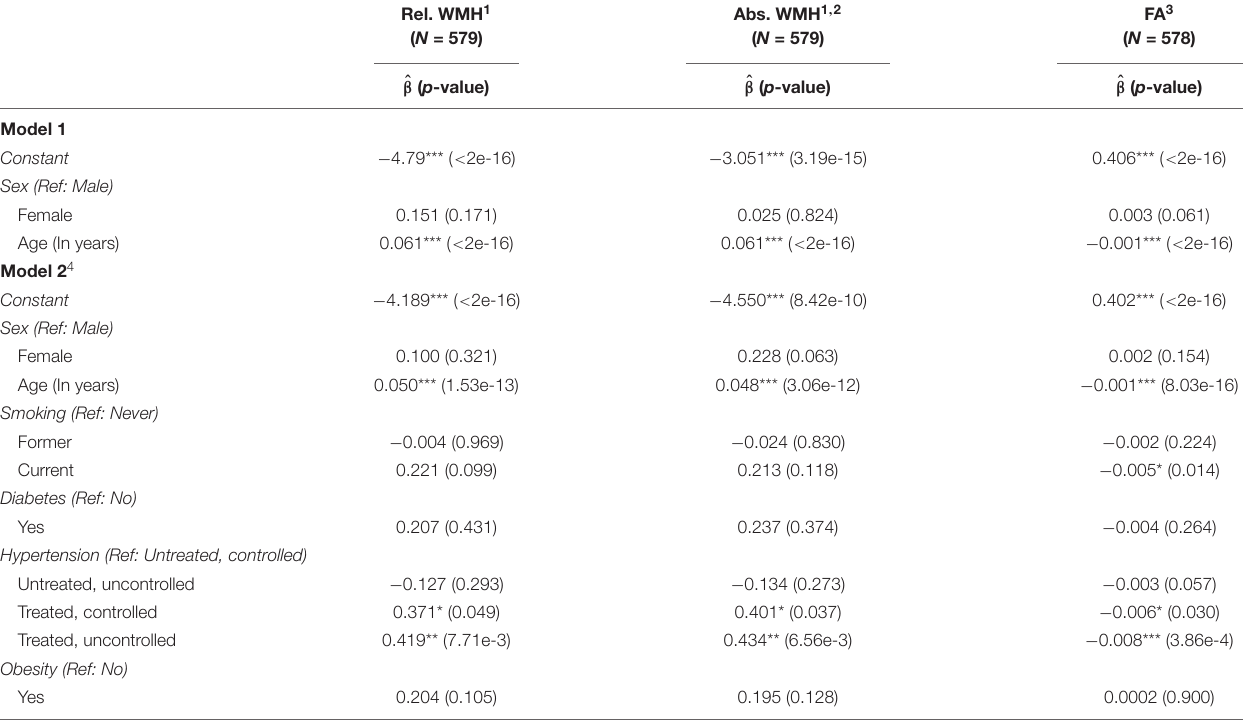
TABLE 2 | Associations (main effects) of risk factors with MRI markers.